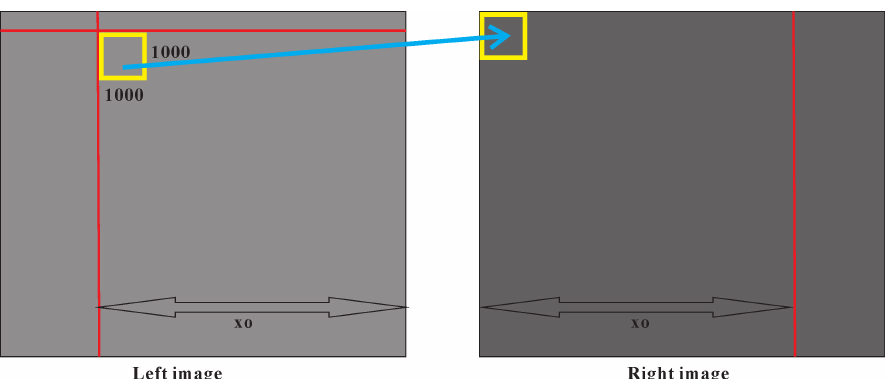
Figure 4. Image blocking of LR-SuperGlue in forward images, lateral images do same (the yellow box and blue arrow represent the corresponding image